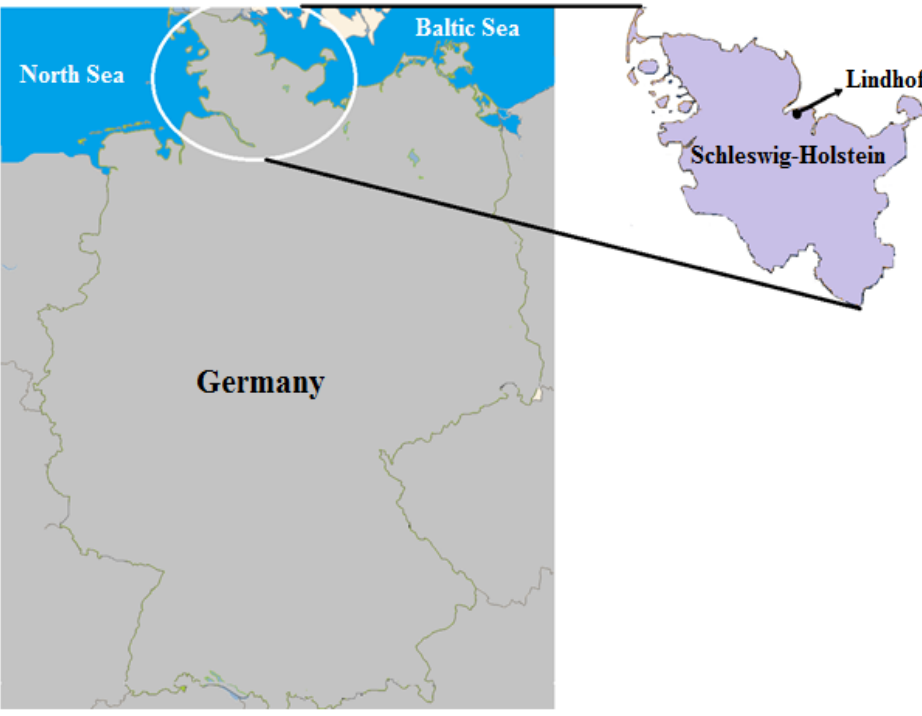
Figure 2. Location of the study area.